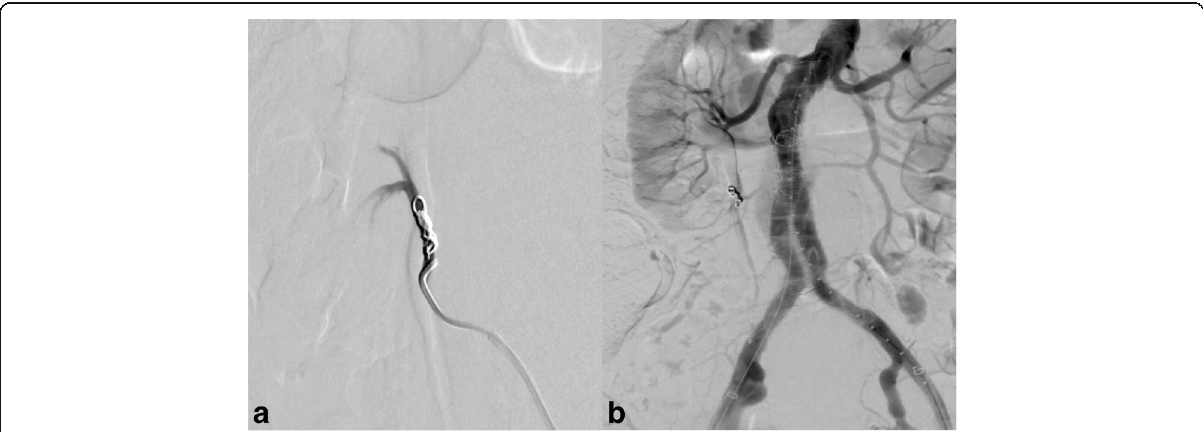
Fig. 2 Angiogram during operation. a The right ARA was embolized using a coil. b The final aortogram showed that the right kidney was well